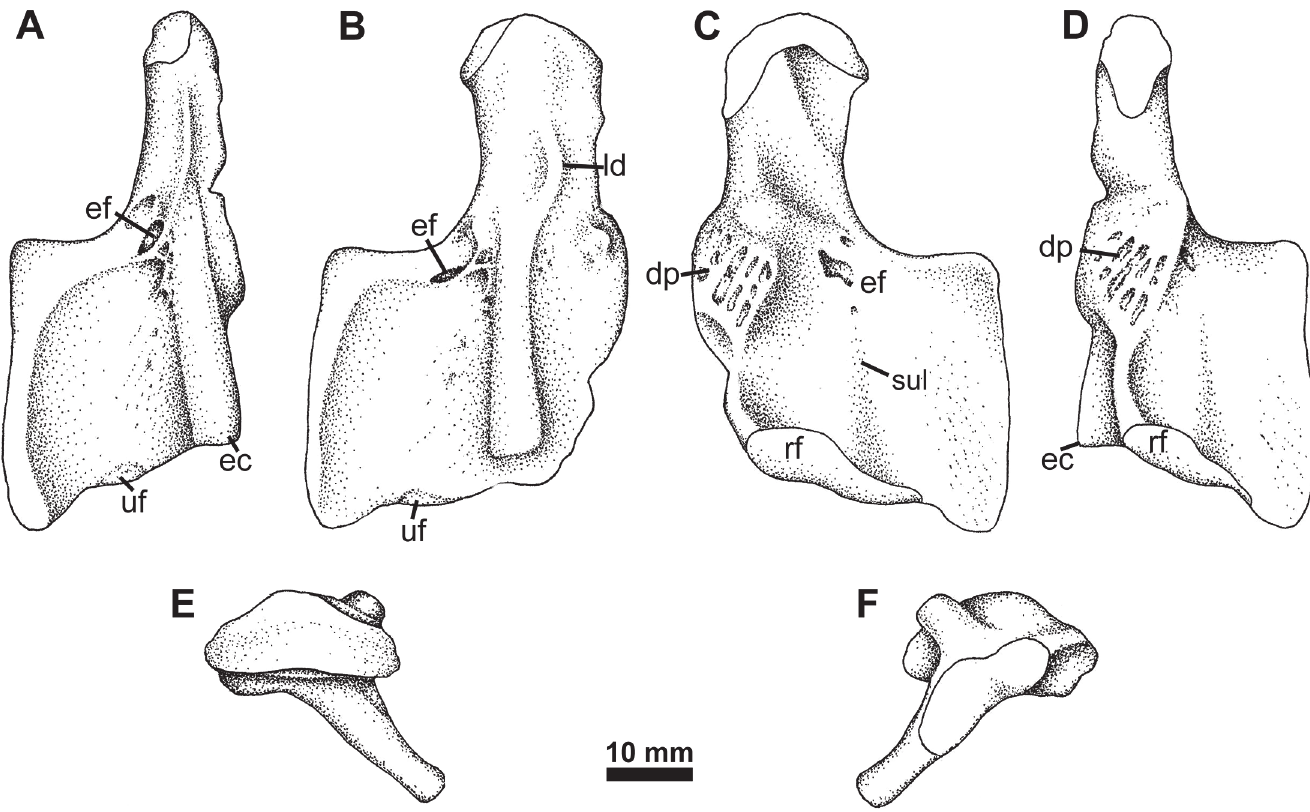
Fig 5. Humerus Type 2. RM 20.6707, right humerus in A, oblique posterior, B, dorsal, C, ventral, and D, oblique posterior views. Abbreviations : dp , deltopectoral crest; ec , ectepicondyle; ef , entepicondylar foramen; ld , latissimus dorsi scar; rf , radial facet; sul , distal sulcus; uf , ulnar